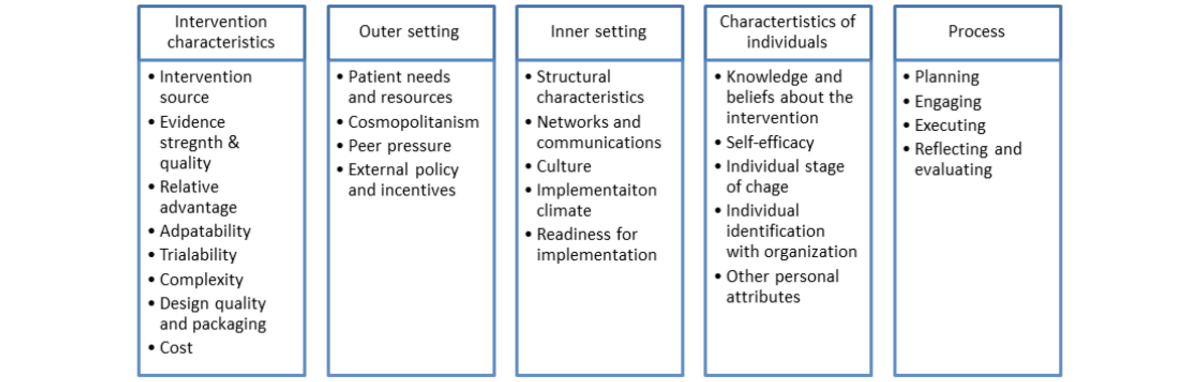
Figure 3. Consolidated framework for implementation research constructs (adapted from Damschroder [79]).